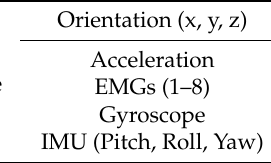
Table 1. Myo device dataset format [14].